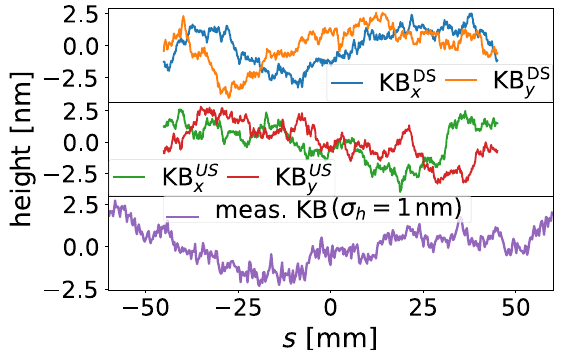
FIG. 2. Numerically generated surface profiles with rms profile error of σ h ¼ 1 . 5 nm (top panel corresponding to the downstream Kirkpatrick-Baez (KB) mirrors and middle panel to the upstream ones). The subscripts x and y symbolize if the long axis of the mirrors projects on the x or y axis of the beam. For comparison, a mirror actually used and measured at the European XFEL is shown in the bottom panel. It has slightly better rms error compared to the numerically generated ones. For better emphasis on the figure error, the deliberately introduced surface curvature is subtracted for each